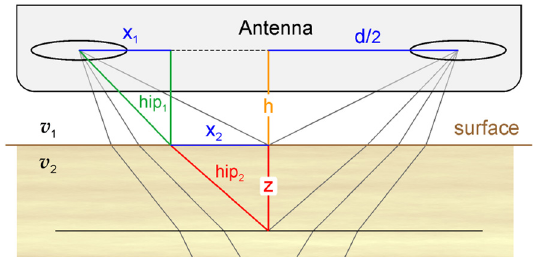
Figure 6. Geometrical considerations for the calculation of Z ( t ).